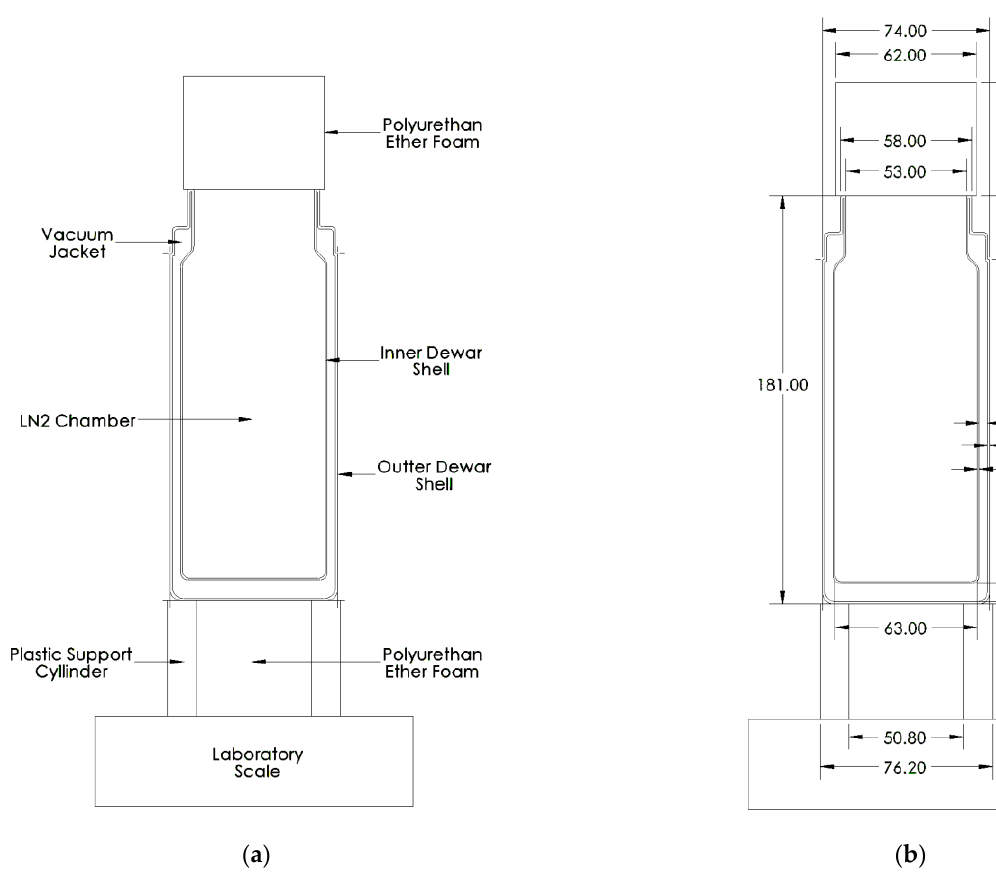
Figure 1. ( a ) Basic experimental setup with component labels with baseline configuration shown; ( b ) Basic experimental setup characteristic dimensions with baseline configuration shown. All measurements are shown in mm.